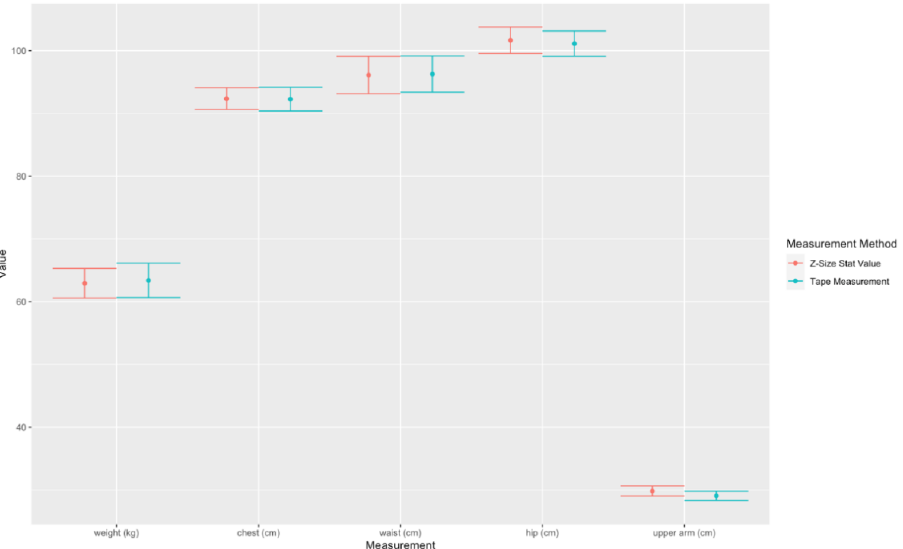
Figure 8. 95% Confidence Interval (CI) plot for the mean measurements (from 75 pregnant volun- teers) of weight, chest, waist, hip, and upper arm between Z-Size Ladies statistical values and tape